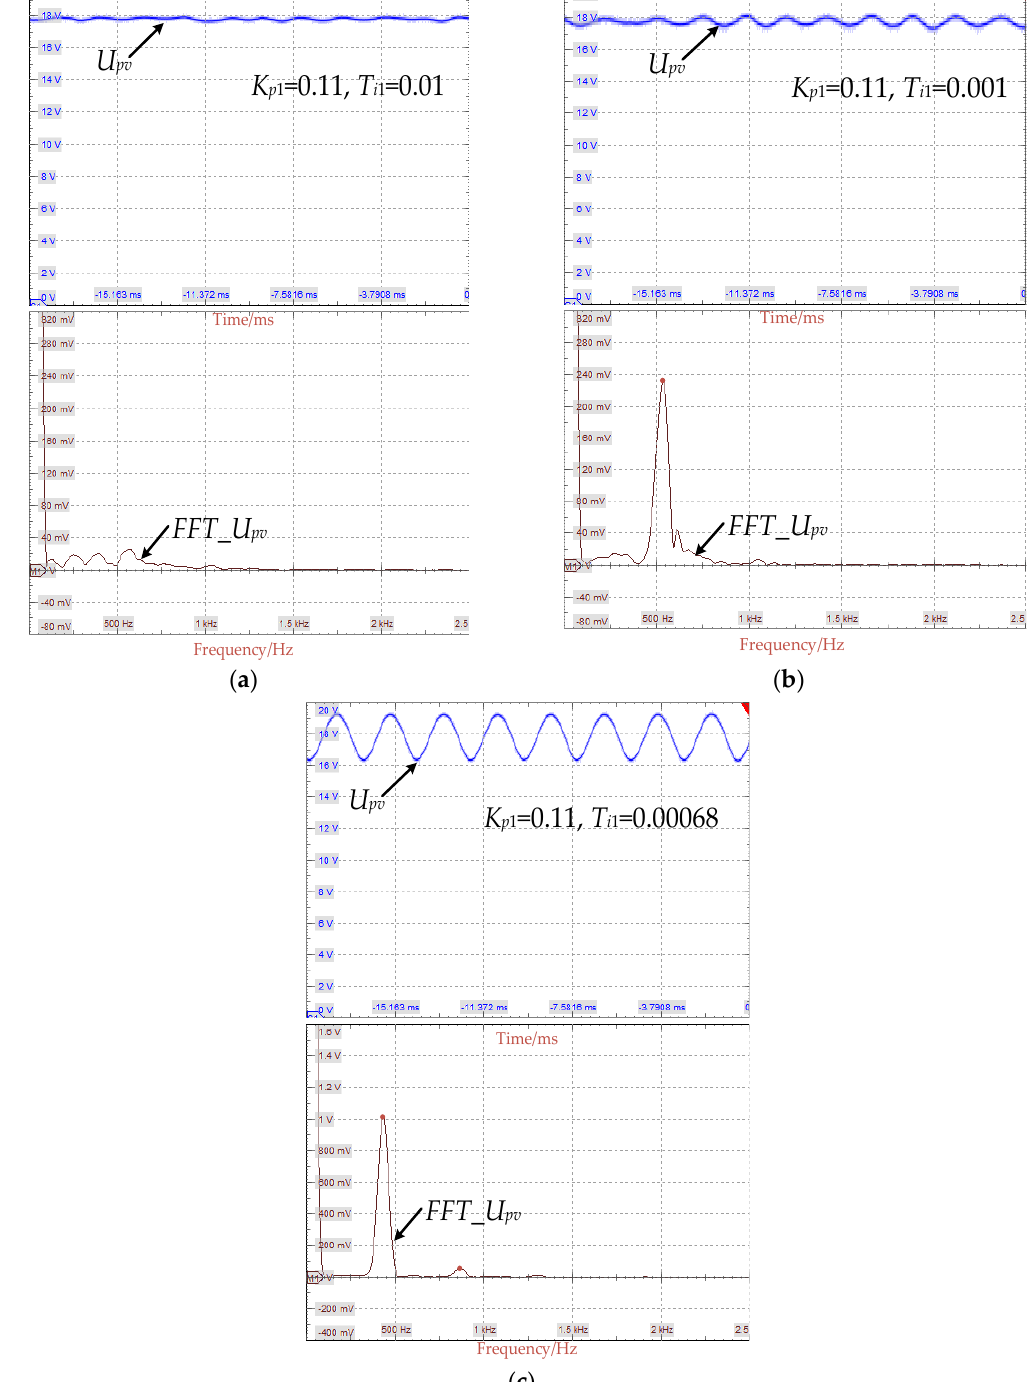
Figure 11. Experimental waveform and FFT analysis results of PV array output voltage u pv in SS at ( a ) [ K p 1 , T i 1 ] = [0.11, 0.01] ; ( b ) [ K p 1 , T i 1 ] = [0.11, 0.001]; ( c ) [ K p 1 , T i 1 ] = [0.11, 0.00068].